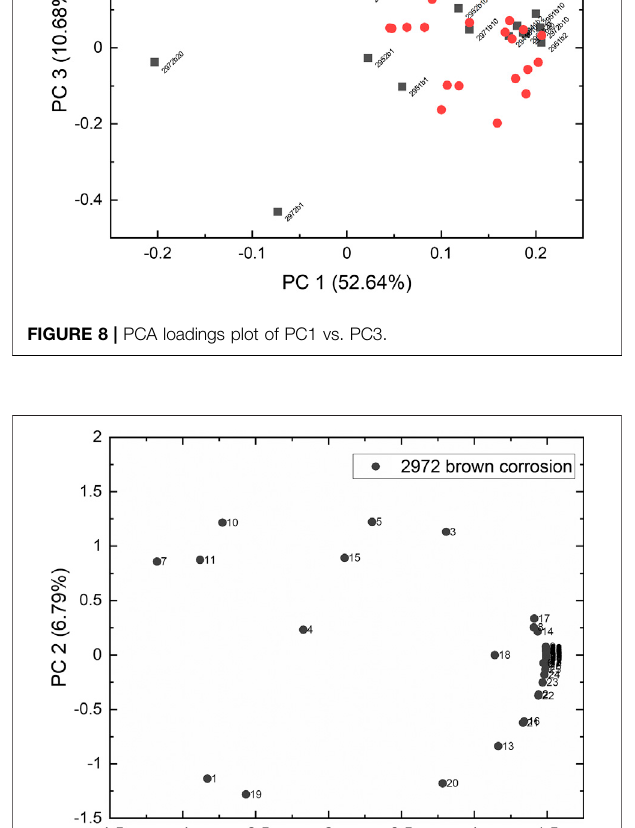
Frontiers in Materials |